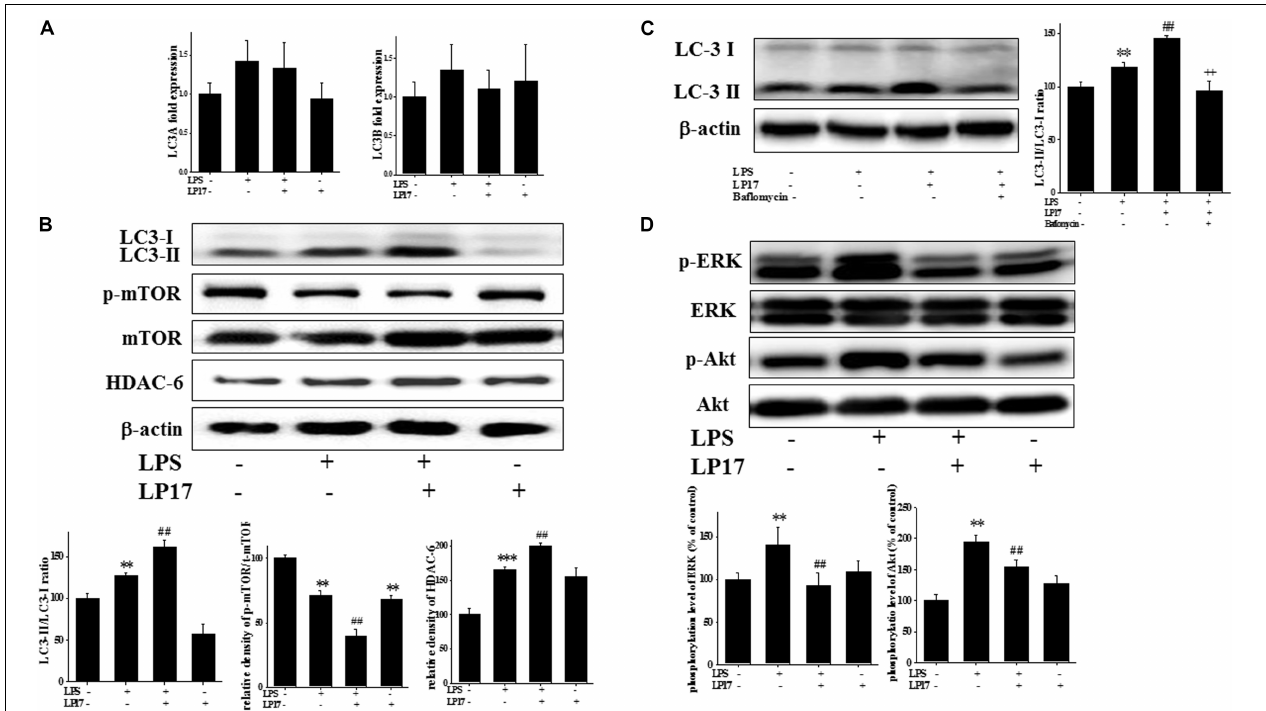
FIGURE 3 | Treatment with LP17 enhanced LC3-II/LC3-I, HDAC6, and p-mTOR expression and inhibited p-ERK and p-Akt protein expression in an LPS-stimulated murine BV-2 microglial cell line ( n = 4/group). (A) Quantitative PCR for LC3A and LC3B in the control, LPS, LPS plus LP17, and LP17-only groups after BV-2 microglial cells were treated with 10 µ g/ml LP17 plus 100 ng/ml LPS for 6 h. Neither LP17 nor LPS affected LC3A and LC3B mRNA expression. (B) Western blot analysis for LC3, HDAC6, and p-mTOR expression in the control, LPS, LPS plus LP17, and LP17-only groups after the treatment of BV-2 microglial cells with 10 µ g/ml LP17 plus 100 ng/ml LPS for 16, 16, and 2 h, respectively. LP17 significantly enhanced the LPS-induced increase in the LC-3-II/LC-3-I ratio, attenuated the LPS-induced down-regulation of p-mTOR, and enhanced the LPS-induced upregulation of HDAC6 protein expression. (C) Western blot analysis for LC3-II/LC3-I ratio in the control, LPS, LPS plus LP17, and LPS plus LP17 + pretreatment of bafilomycin groups after BV-2 microglial cells were treated with 10 µ g/ml LP17, 100 ng/ml LPS plus 5 nM bafilomycin for 16 h. Pretreatment with bafilomycin for 1 h significantly inhibited the LP17-induced increase of the LC3-II/LC3-I ratio. (D) Western blot analysis for p-Akt and p-ERK after the treatment of BV-2 microglial cells with 10 µ g/ml LP17 plus 100 ng/ml LPS for 16 h. The results showed that LP17 significantly inhibited the LPS-induced upregulation of the p-Akt and p-ERK proteins. The bars represent means ± SEM. The data were analyzed using two-way ANOVA. ∗∗ P < 0.05; ∗∗∗ P < 0.001 versus the control group; ## P < 0.05 versus the LPS group; ++ P < 0.05 versus the LPS plus LP17